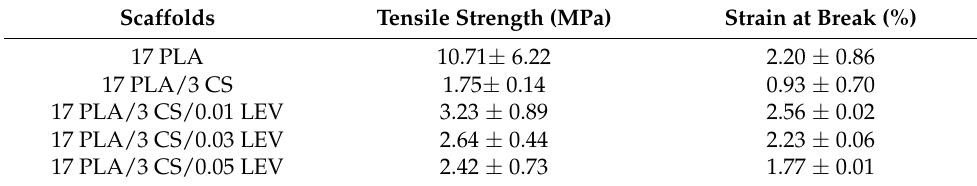
Table 3. Tensile testing results of all